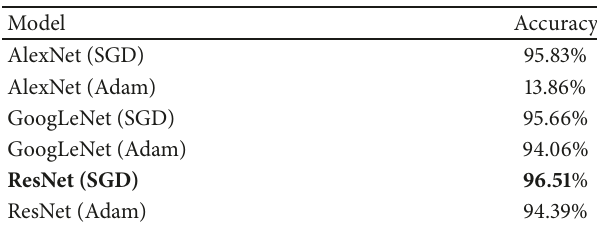
Figure 5: ResNet bottleneck residual building block [26]. Table 3: Model recognition accuracy.